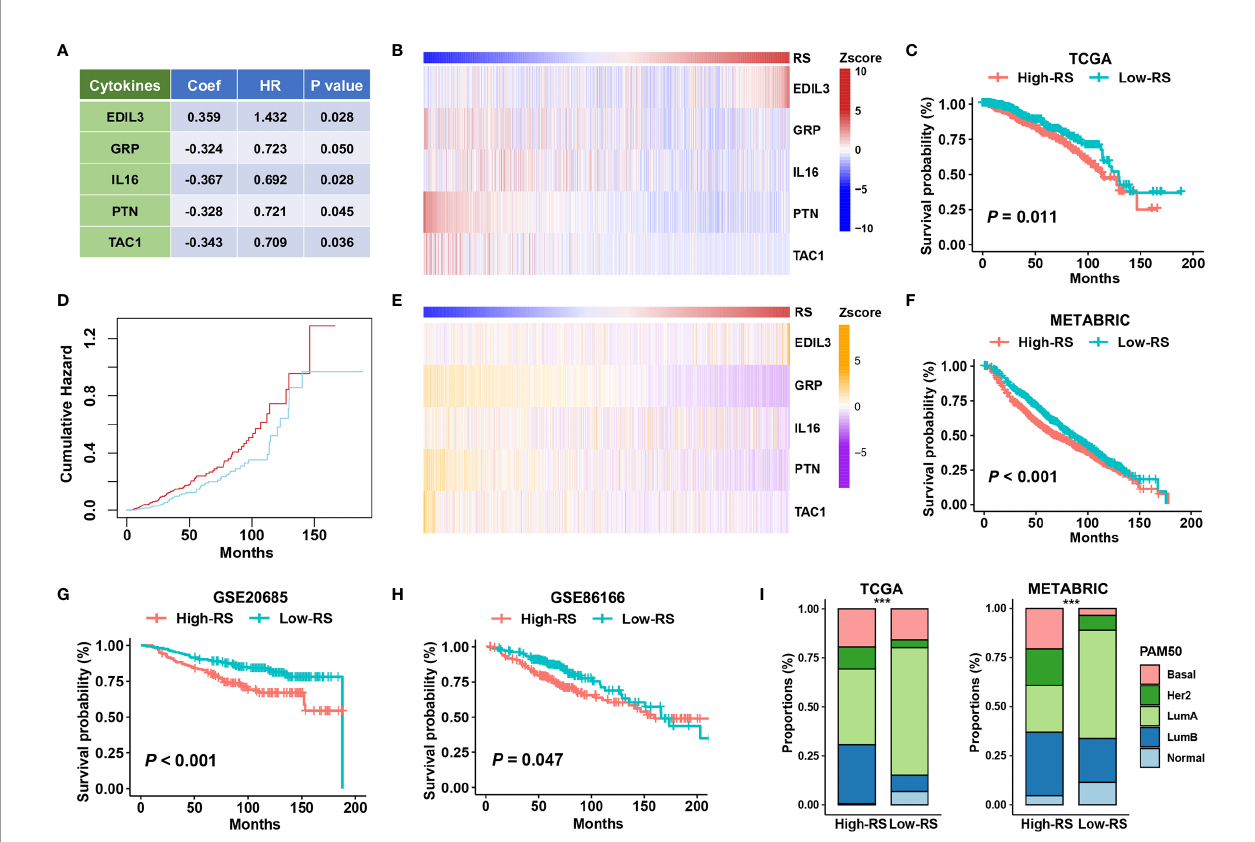
FIGURE 3 | The association of fi ve-cytokine signature status with clinical outcomes. (A) The features of the fi ve-cytokine signature in the training data (TCGA). Coef, coef fi cient; HR, hazard ratio. (B) The heatmap plot for the expression level of each cytokine across TCGA samples. (C, D) The training results in the TCGA dataset. Kaplan ‐ Meier survival analysis and cumulative hazard curves using median cutoff RS. P value indicated by log-rank test. (E, F) The validation results in the METABRIC dataset. The heatmap plot for the expression level of included fi ve cytokines across METABRIC samples, and Kaplan ‐ Meier survival analysis using median cutoff RS of fi ve-cytokine signature. (G, H) Further validation in GSE20685 and GSE86166 datasets using median cutoff RS both suggested that the high-RS level was associated with the poor prognosis. (I) Grouping BC patients into fi ve PAM50 subtypes (Lum A, Lum B, HER2-enriched, Basal-like, and Normal-like) based on fi ve-cytokine signature status. *** P <